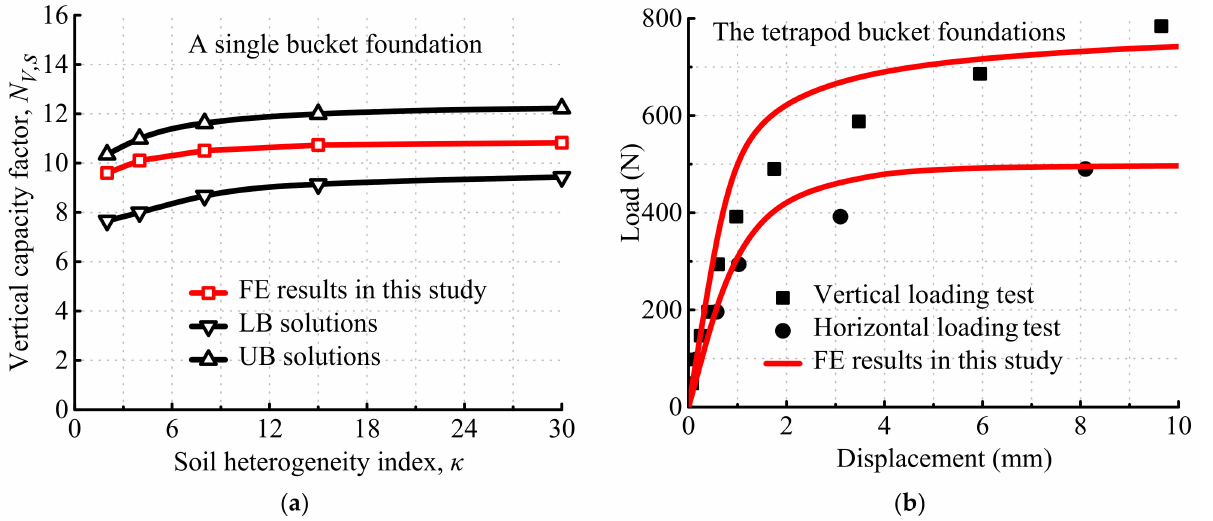
Figure 4. Comparisons between finite-element results in this study and ( a ) analytic solutions of a single bucket foundation or ( b ) model tests of the tetrapod bucket